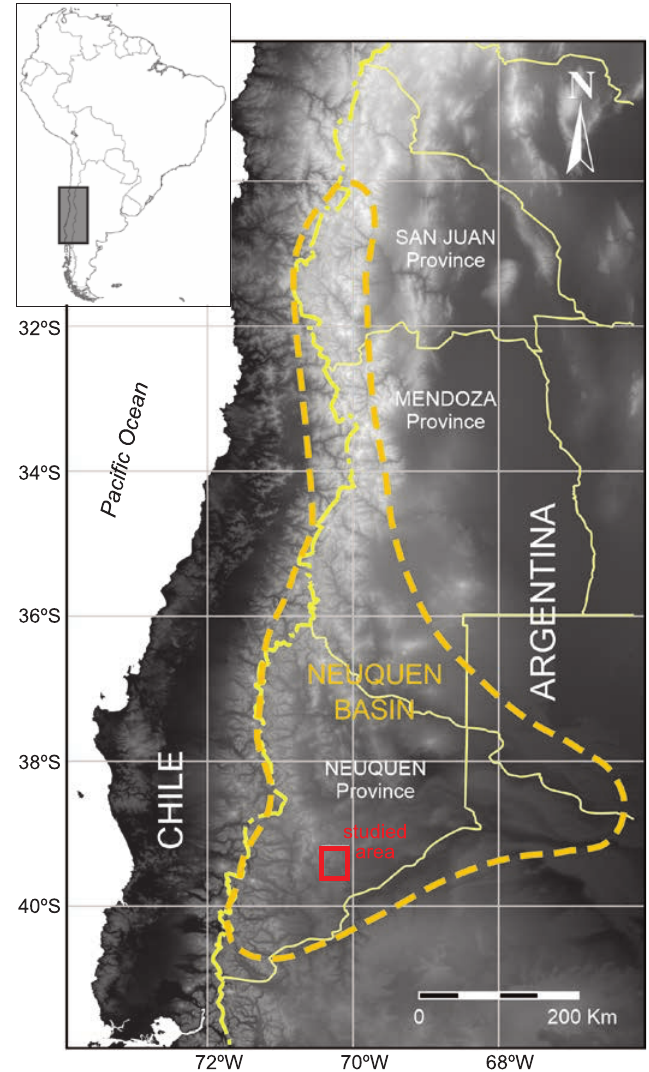
Fig. 1. Generalized outline of the Neuquén Basin, showing the location of the studied area of the Paso Flores Formation, Neuquén Province, Patagonia, Argentina (modified from Vergani et al. 1995). Image taken by NASA, July